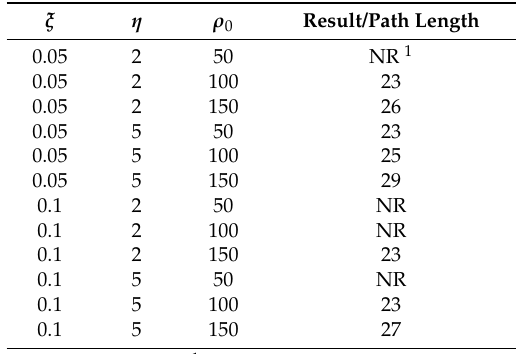
Table 4. Path length on map-2 for potential field method.